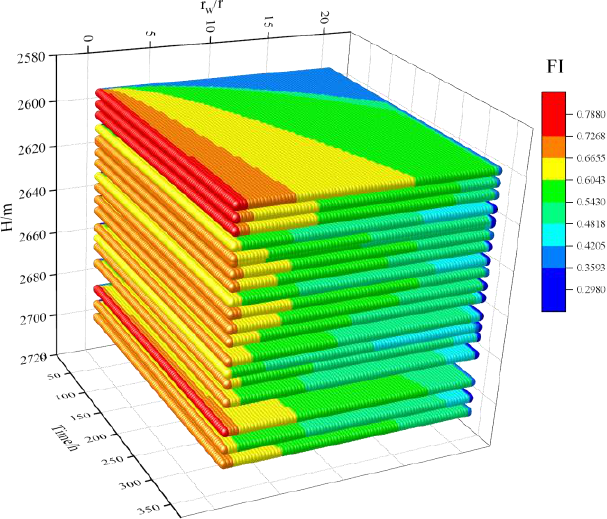
Figure 8. Logging data of the Da’anzhai section (Well NC2H). According to the logging data, the Young’s modulus of the Da’anzhai section of Well NC2H ranges from 18.23 to 23.70 GPa, the tensile strength ranges from 6.27 to 8.18 MPa, the shale content ranges from 0.39 to 0.65, and the Poisson’s ratio varies between 0.18 and 0.24. The maximum horizontal principal stress coefficient ( σ H ) ranges from 2.51 to 3.32, the minimum horizontal principal stress coefficient ( σ h ) from 2.20 to 2.41, and the vertical in situ stress coefficient ( σ v ) is about 2.55. The measured parameters are brought into the fracability evaluation model, and the variation law of the FI of the Da’anzhai Section and the depth, time, and dimensionless distance from the wellbore axis are calculated, as shown in Figure 9.